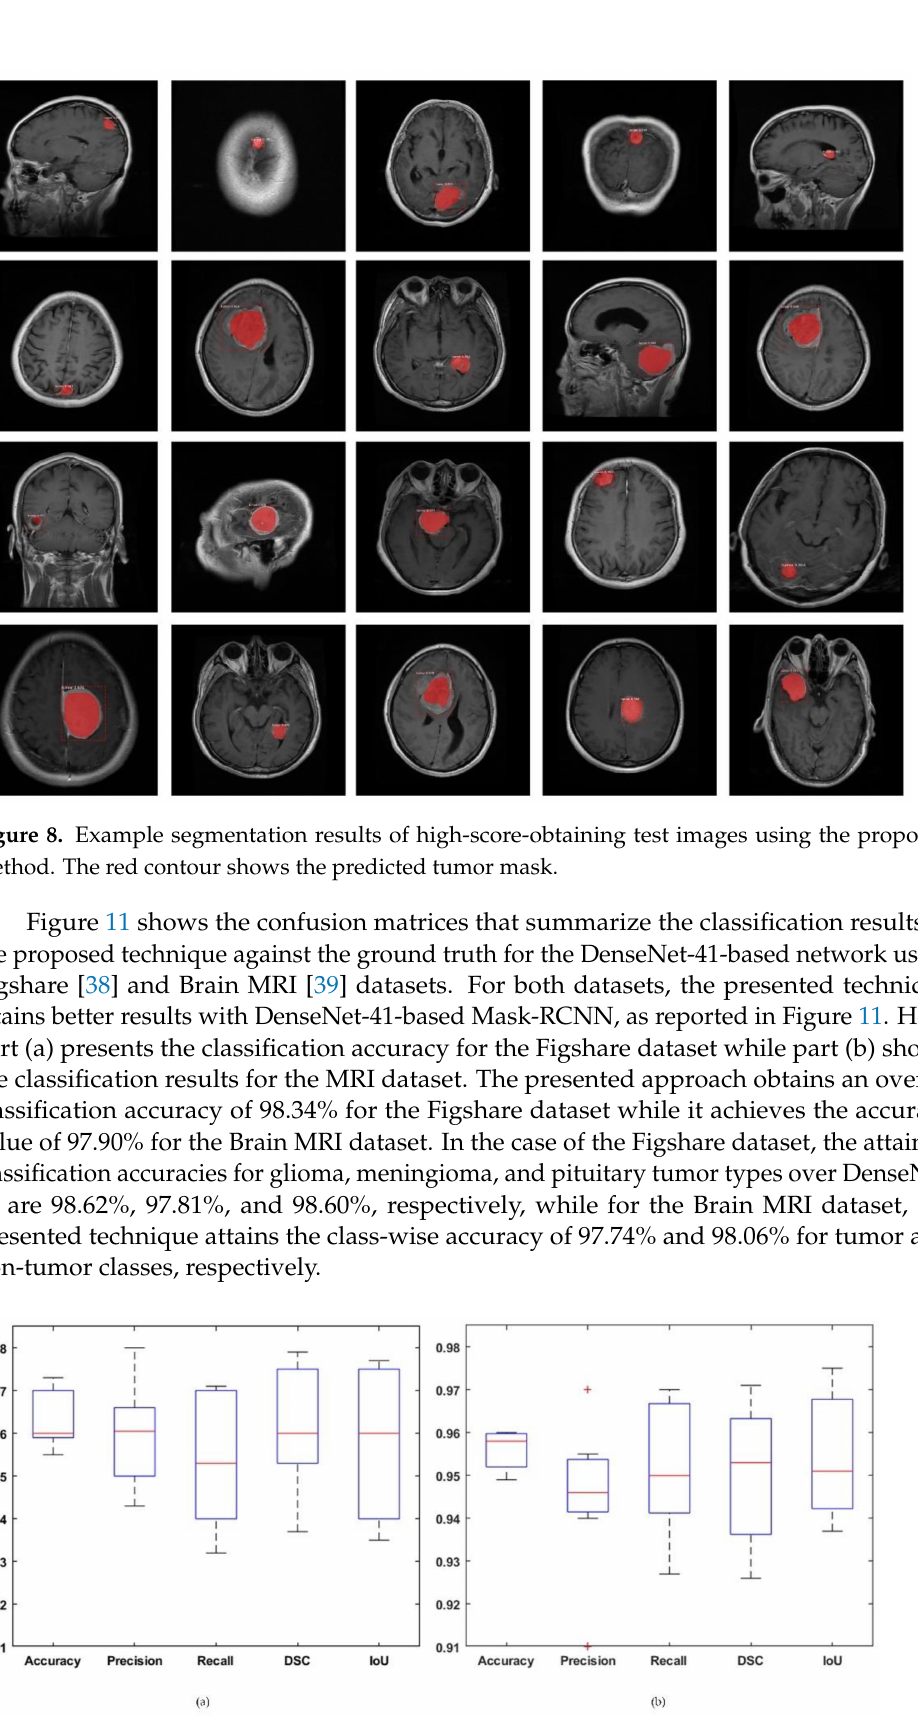
Figure 9. Tumor localization results of the proposed approach over datasets using DenseNet-41 ( a ) Figshare, ( b ) Brain MRI dataset. + sign shows the outer value which is larger than the other